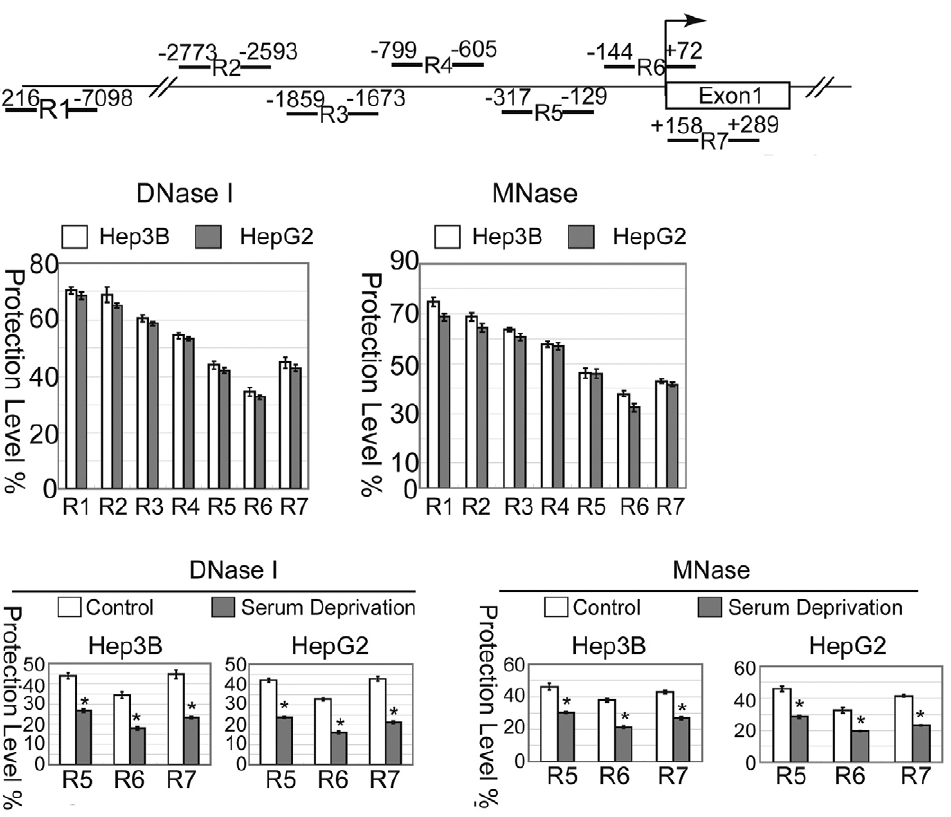
Figure 3. The proximal region of the DRAM promoter is sensitive to nuclease digestion. (A) Schematic representation of the primer sets used for CHART-PCR. (B) R6 region of the DRAM promoter is more sensitive to DNase I and MNase digestion. The genomic DNA was isolated from Hep3B and HepG2 cells and analyzed by quantitative PCR. The data was shown as percentage of digested DNAs to undigested DNAs. (C) Serum deprivation increases the accessibility of R5, R6 and R7 regions to nuclease digestion in Hep3B and HepG2 cells.